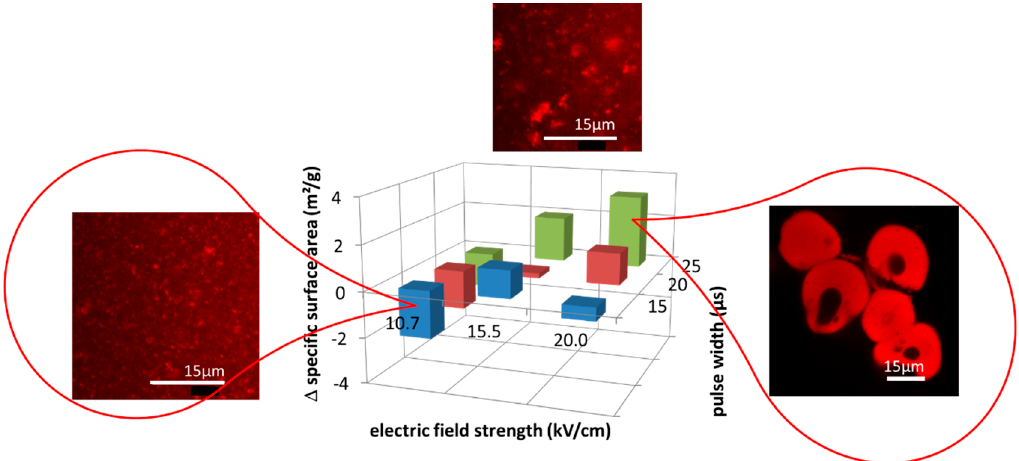
Figure 4. Effect of PEF on SSA of rehydrated CM at different electric field strengths (10.7–20 kV/cm) and pulse width (15–25 μ s), applying a specific energy of 25 kJ/kg and an inlet temperature of 10 °C, Δ SSA = SSA before PEF − SSA after PEF.